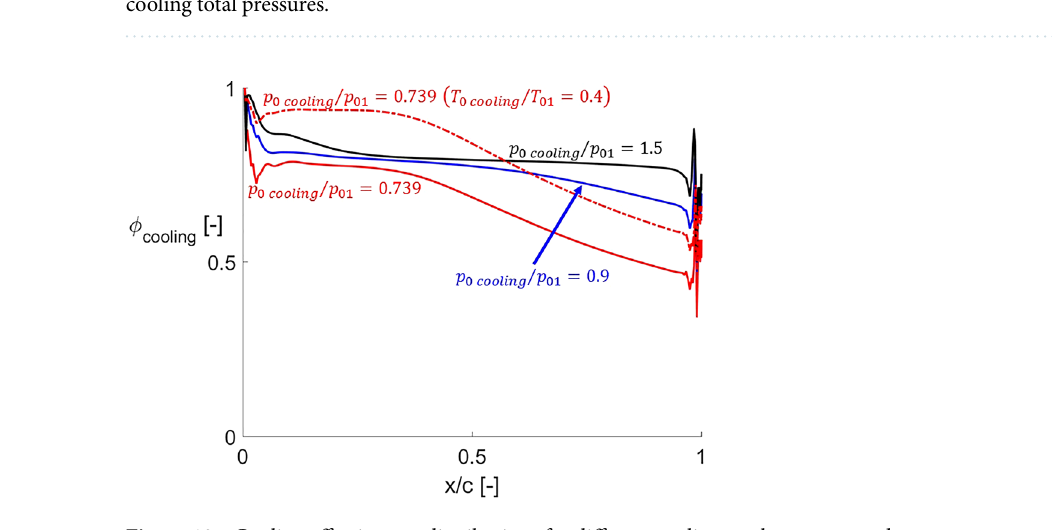
Figure 12. Cooling effectiveness distributions for different cooling total pressures and